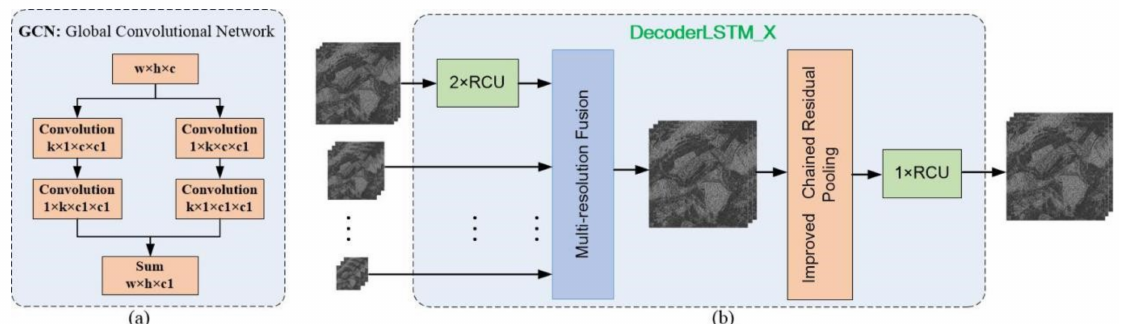
Figure 5. ( a ) The GCN network. ( b ) The network of DecoderLSTM_X.